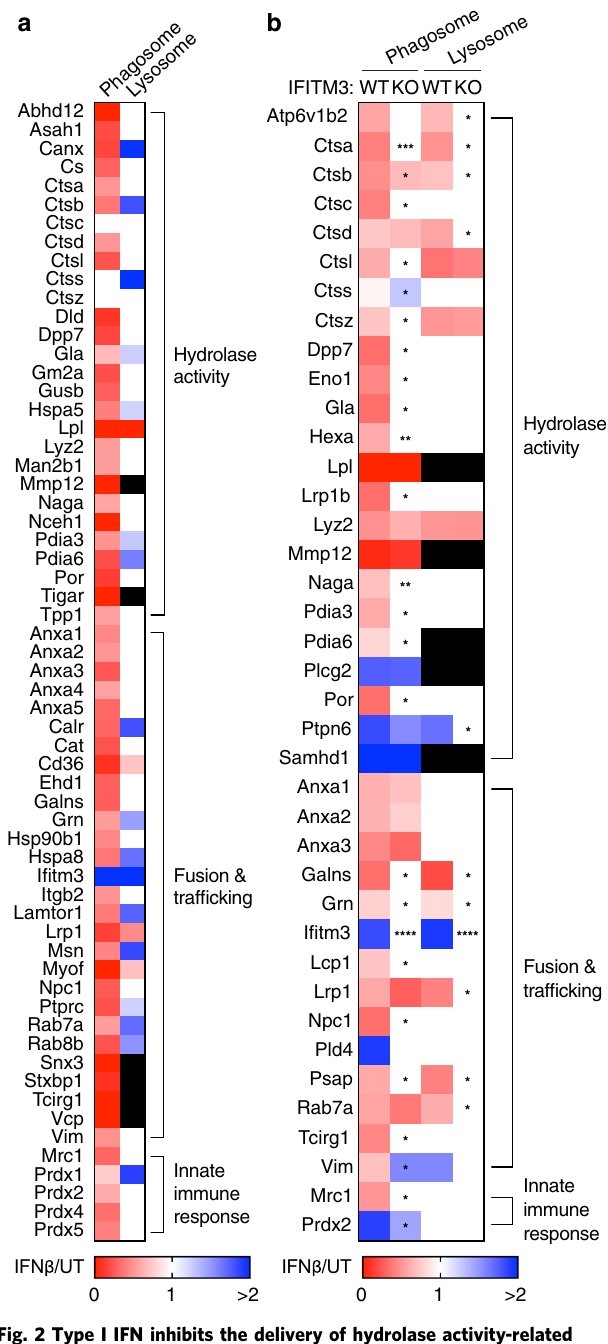
Fig. 2 Type I IFN inhibits the delivery of hydrolase activity-related proteins to phagosomes. Proteomics data obtained by mass spectrometry of phagosomes and lysosomes isolated from ( a ) WT BMDMs and ( b ) IFITM3 KO BMDMs. Legend denotes relative protein abundance between IFN β treatment and UT controls. Black box indicates undetected proteins. Data shown are means for at least n = 3 independent experiments. P value was calculated using two-way ANOVA. * P < 0.05, ** P < 0.01, *** P < 0.001, **** P <